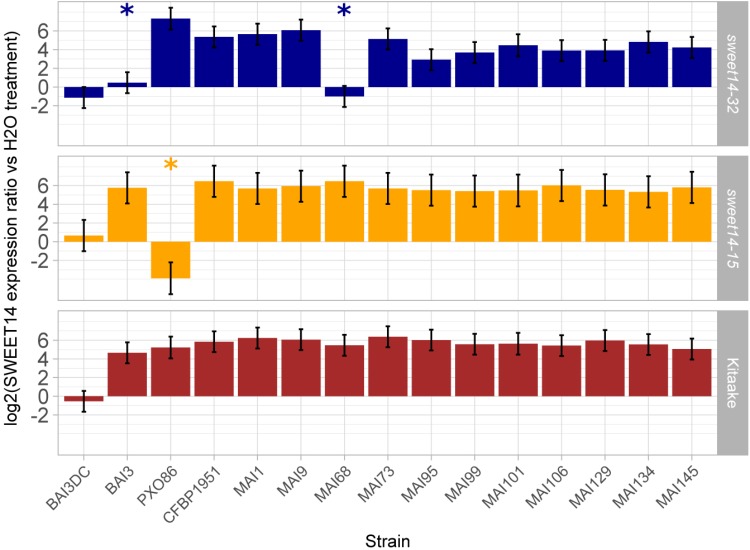
Profiling Malian strains OsSWEET14-induction activities on EBE edited rice lines. Q-RT-PCR was conducted on rice RNA extracted from leaf samples 48 h after infiltration of the designated bacterial strains (BAI3DC refers to the talC mutant of BAI3). The barplot reports least-square means and standard errors computed from a mixed linear model of the log2-transformed SWEET14 induction ratio relative to water treatment of the corresponding rice line (174 observations from four independent experiments). Likelihood ratio tests demonstrated that the model explaining OsSWEET14 induction ratio as a function of rice line and strain and including a random component performed better than a model incorporating fixed effects alone (L-ratio = 195.48; p-value < 0.00001). The null hypothesis that induction ratio is inferior or equal to the value of the negative control strain BAI3DC was systematically rejected (p-value < 0.05 with Sidak adjustment method) except for treatments designated with an asterisk.